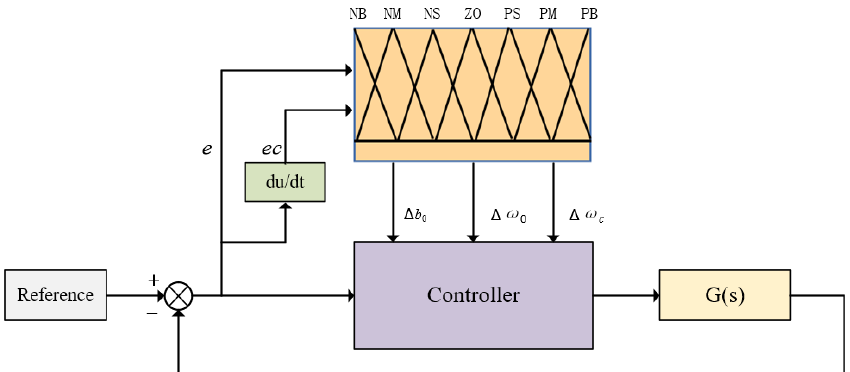
Figure 5. The structure of fuzzy adaptive